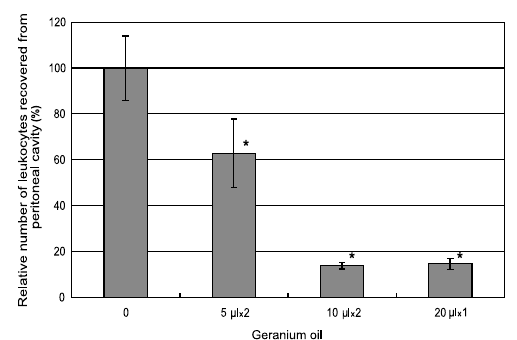
FIG. 2. Effect of geranium oil on casein-induced leukocyte infiltration. Geranium oil was injected 2 and 4 h after casein induction. After 6 h, peritoneal leukocytes were counted. Each value represents an average of four to six samples and the standard deviation. * p B / 0.05.